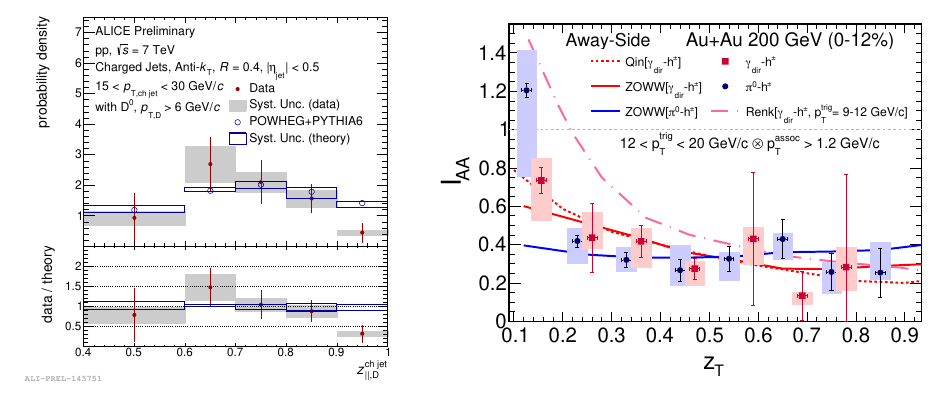
Figure 8. Left: Probability density distribution of the jet momentum fraction, z ch , jet mesons in the direction of the jet axis for D 0 -meson tagged jets in pp collisions at √ s = 7 TeV for 15 < p T , chjet < 30 GeV / c [13]. Right: The I γ dir function of z T . The points for I γ dir